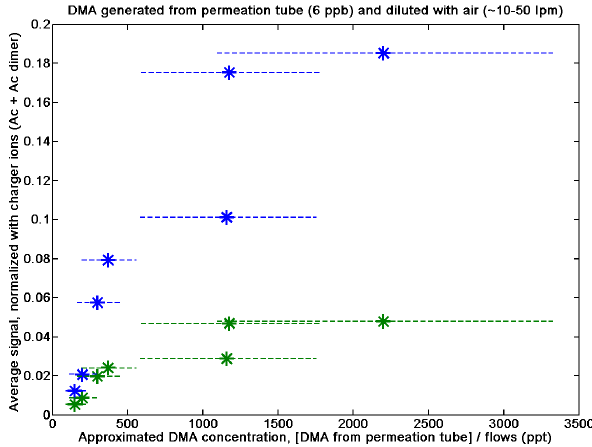
Figure 6. Measurement data from CI-APi-TOF, presented as the normalized average signals of ion counts per second. Green stars are for H + (DMA) 1 , and blue stars are for H + (Ac) 1 (DMA) 1 . The error bars in the direction of the x axis are calculated using known sources of error and propagation of uncertainty. The error in the direction of the y axis is assumed to be